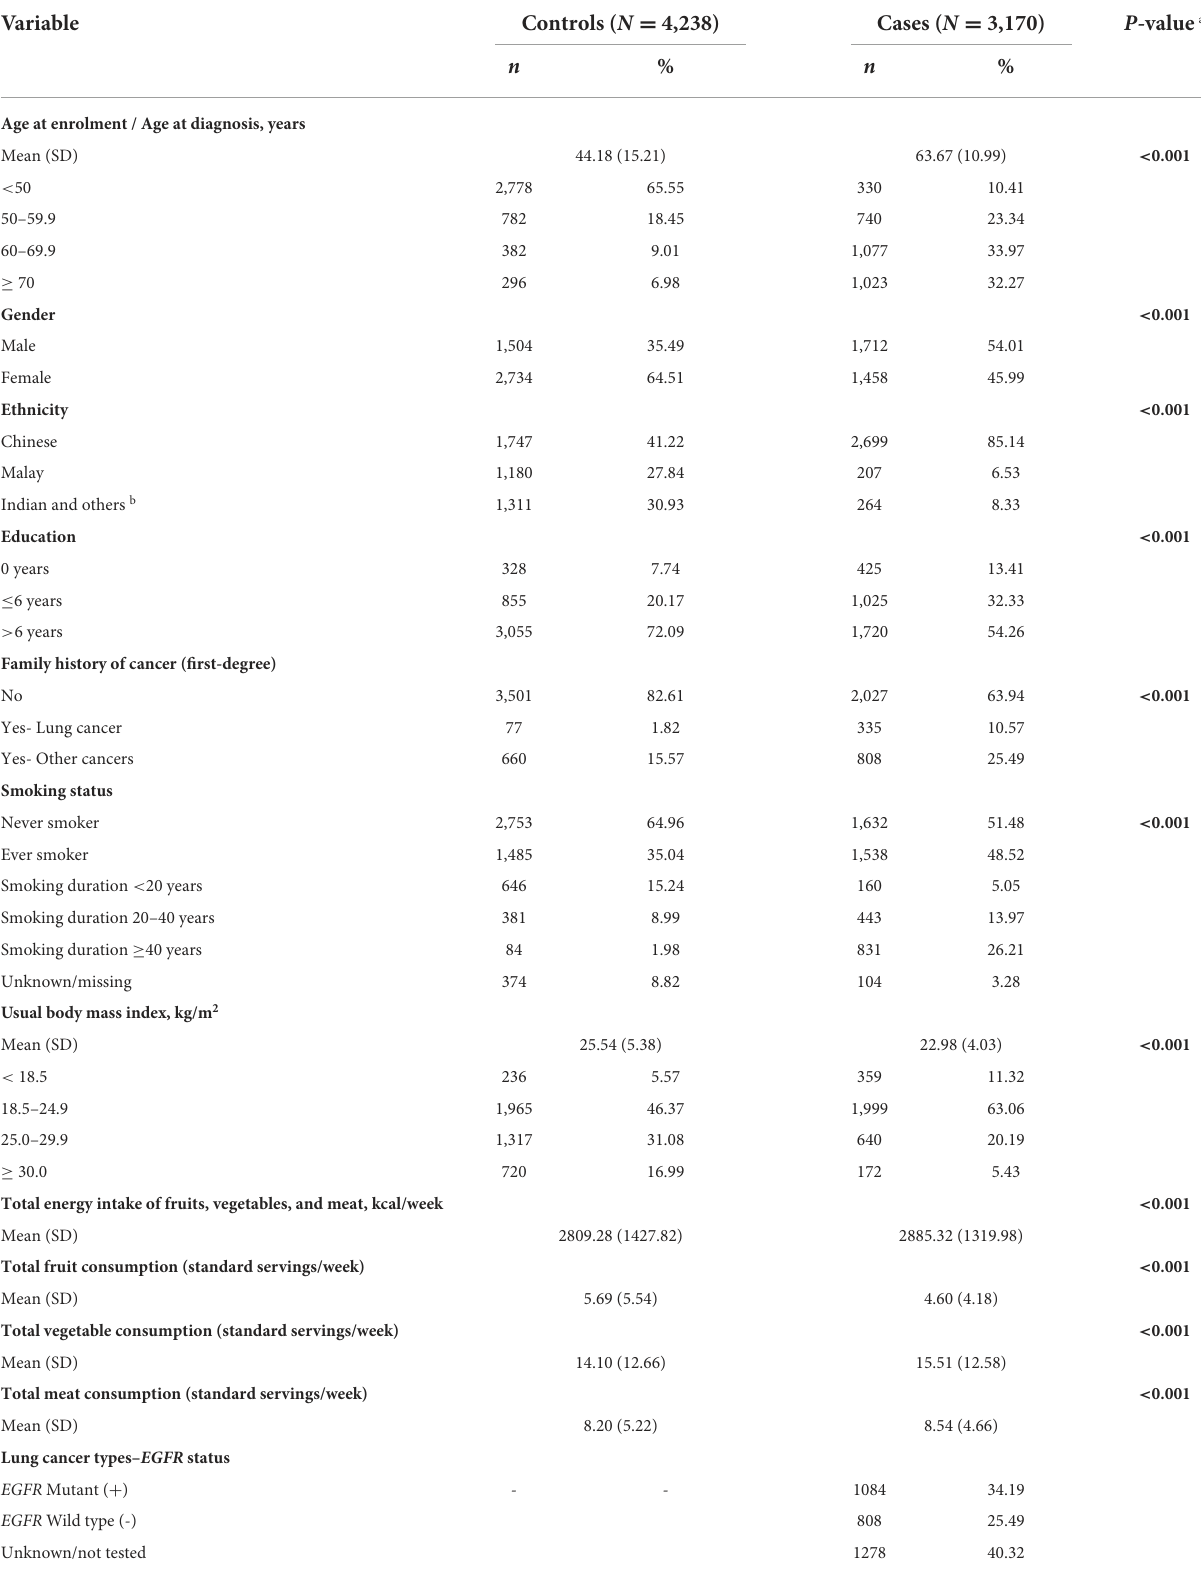
TABLE 1 Baseline characteristics of lung cancer cases and controls.